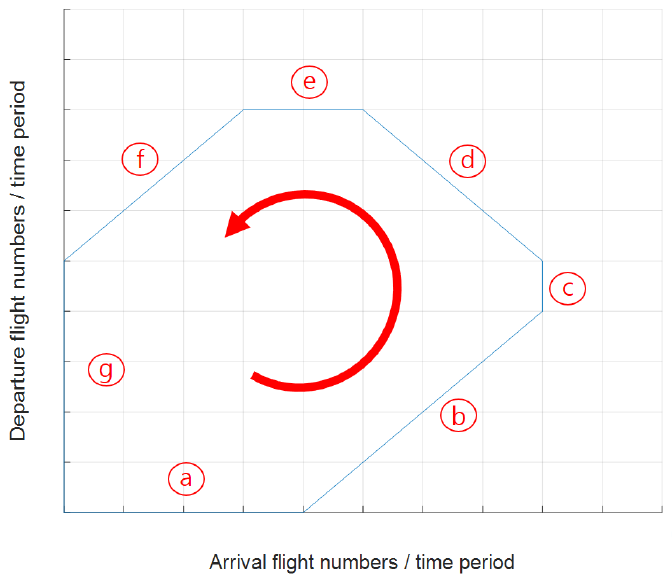
Figure 24. Integer pairs of departures and arrivals: section ⓐ is the number of accommodated aircraft when the vertiport is empty; ⓑ and ⓕ are the priority arrival sections; ⓒ and ⓔ are the free-operation sections; section ⓓ has the maximum of feasible departure and arrival; and section ⓖ is the section with prepared departure